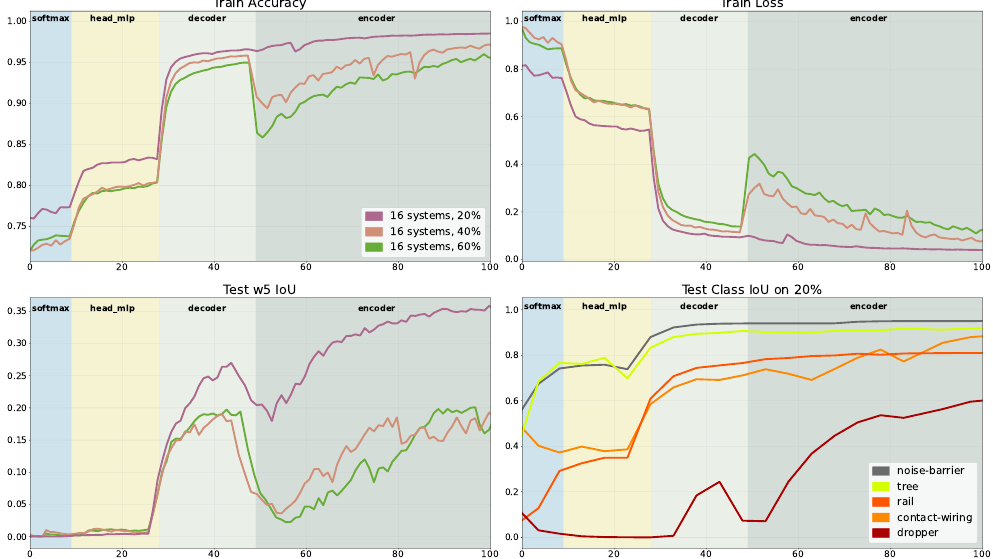
Figure 9. Detection results after finetuning. The background colour change indicates the unlocking of the gradient. The 20% run set slightly outperforms the 40% run. Enabling the gradient for the encoder block needed roughly 15/30 epochs to be